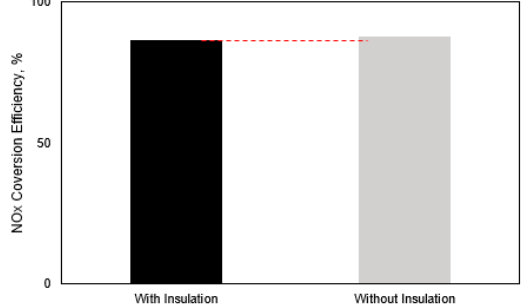
Figure 8. NOx conversion efficiency results with insulation and without insulation.